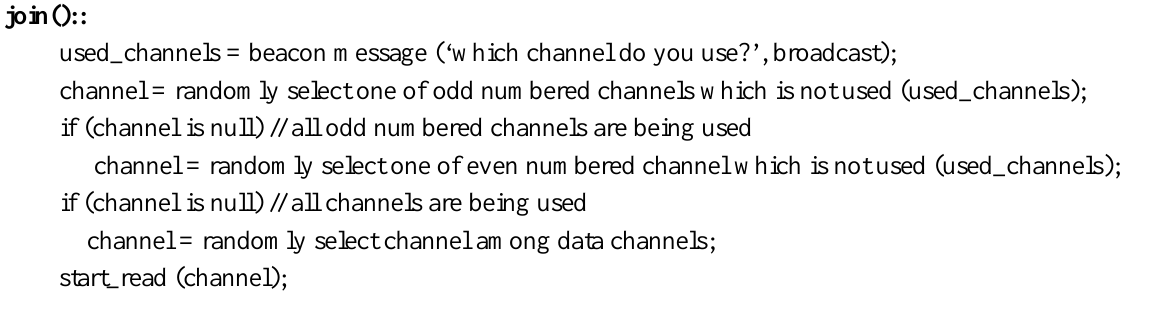
Table 4. Pseudo code of the proposed